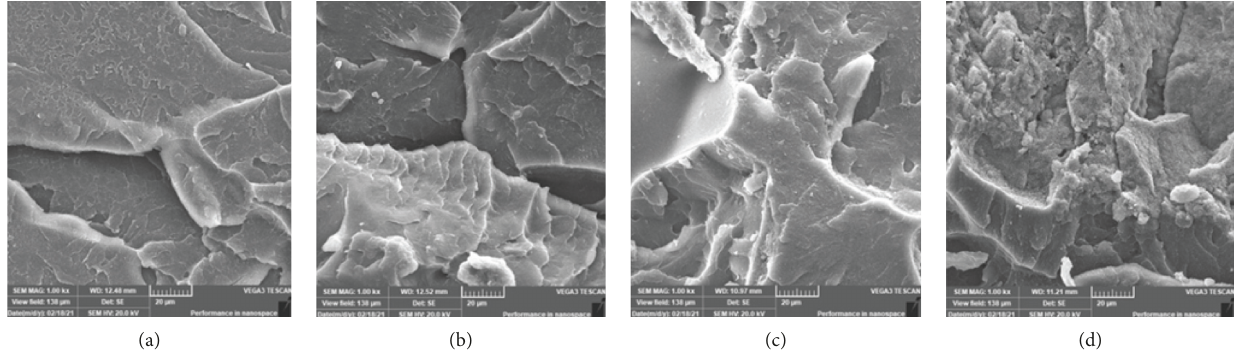
Figure 3: (a)–(d) Representative SEM images of group II specimens. (a) Unmodified 0%NDs, (b) 0.05% NDs-modified specimens, (c) 0.25% NDs-modified specimens, and (d) 0.5% NDs-modified